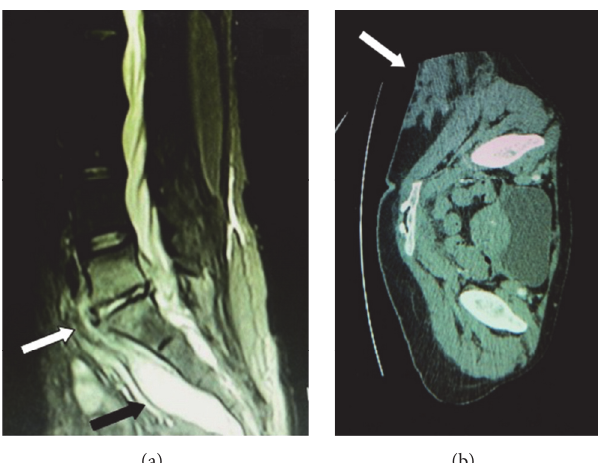
Figure 1: (a) Presacral epidural inflammatory fluid collection (abscess) (black arrow) and adjacent spondylodiscitis that developed at the level of L5-S1 vertebrae (white arrow). Due to its small size the epidural abscess was successfully managed with antibiotics alone. (b) Large abscess of the right buttock (white arrow) that was drained under CT scan